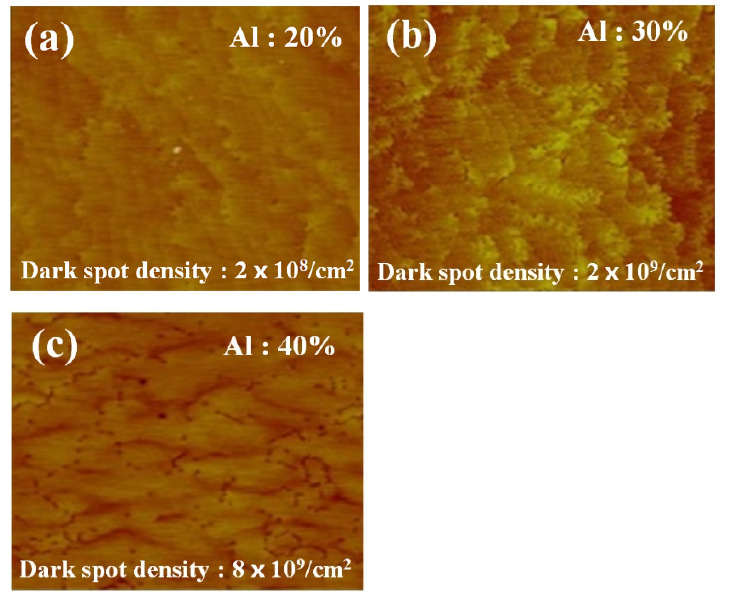
Figure 4. Atomic force microscope (AFM) images of the AlGaN surface according to Al compositions of ( a ) 20 %, ( b ) 30 %, and ( c ) 40 %.